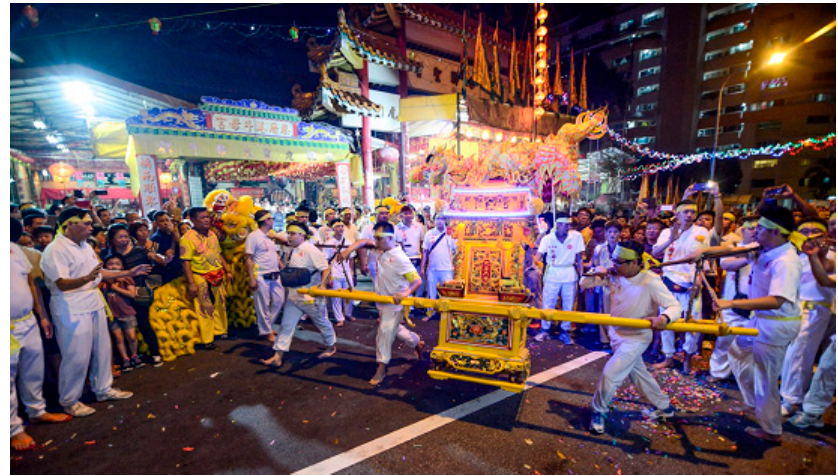
Figure 8. Palanquin bearers swing the palanquin of the Sixth Emperor God at the CCKDMG’s entrance 14 .